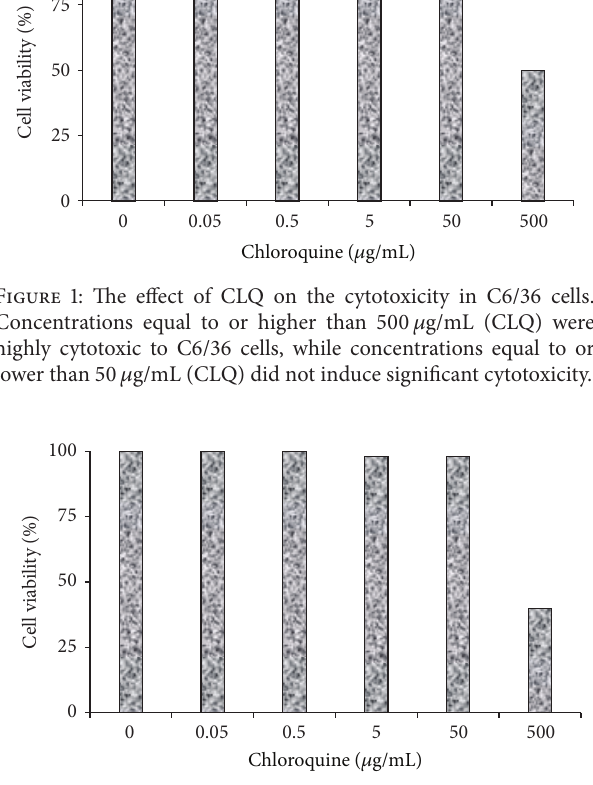
Figure 2: The effect of CLQ on the cytotoxicity in Vero cells. Concentrations equal to or higher than 500 𝜇 g/mL (CLQ) were highly cytotoxic to Vero cells, while concentrations equal to or lower than 50 𝜇 g/mL (CLQ) did not induce significant cytotoxicity.